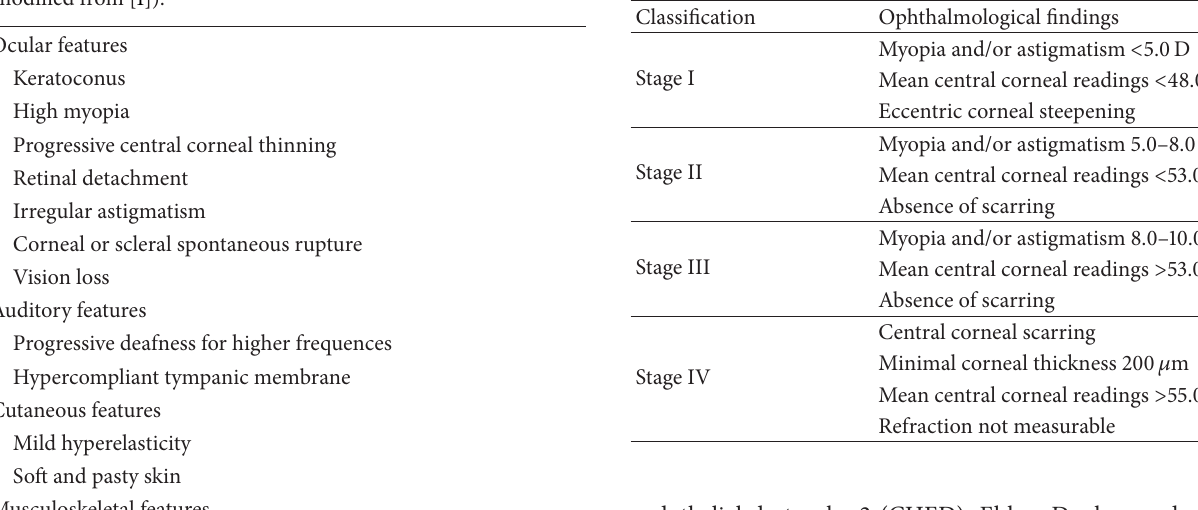
Table 2: Amsler-Krumeich classification of keratoconus (modified from [1,